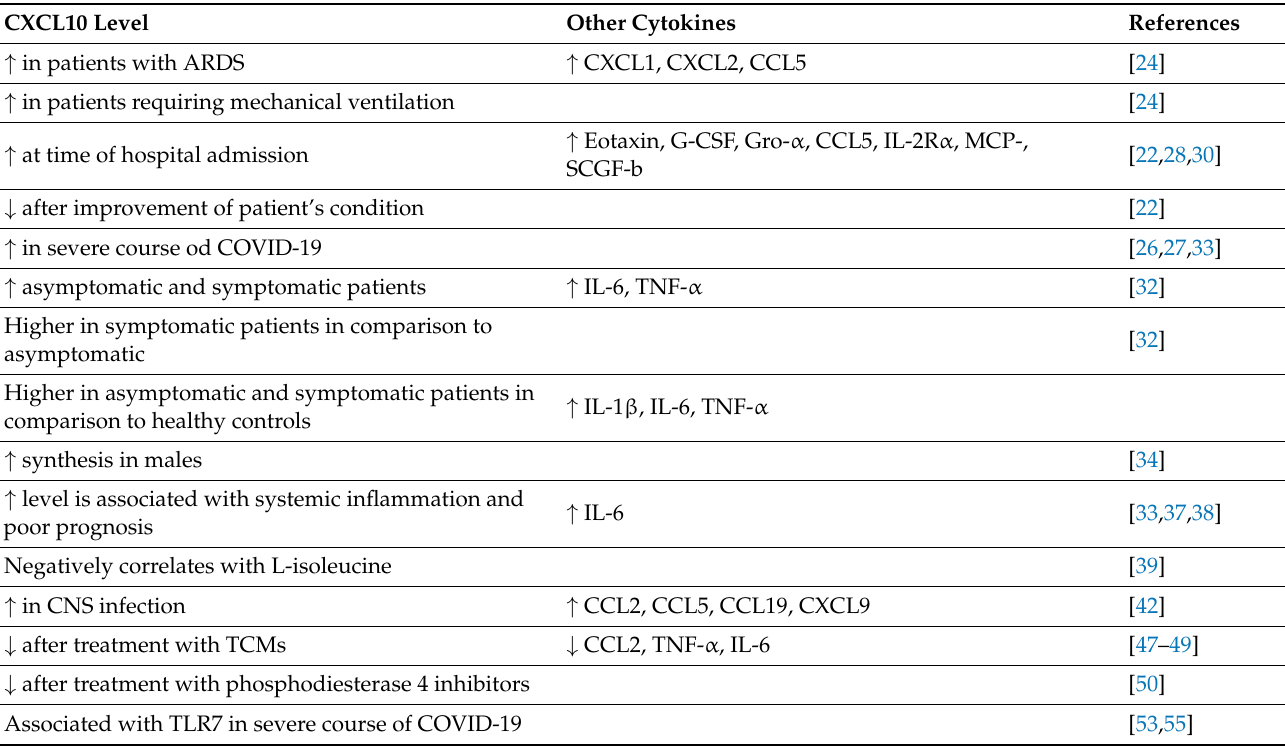
Table 1. The significance of CXCL10 and other cytokines in SARS-CoV-2 infection. Other